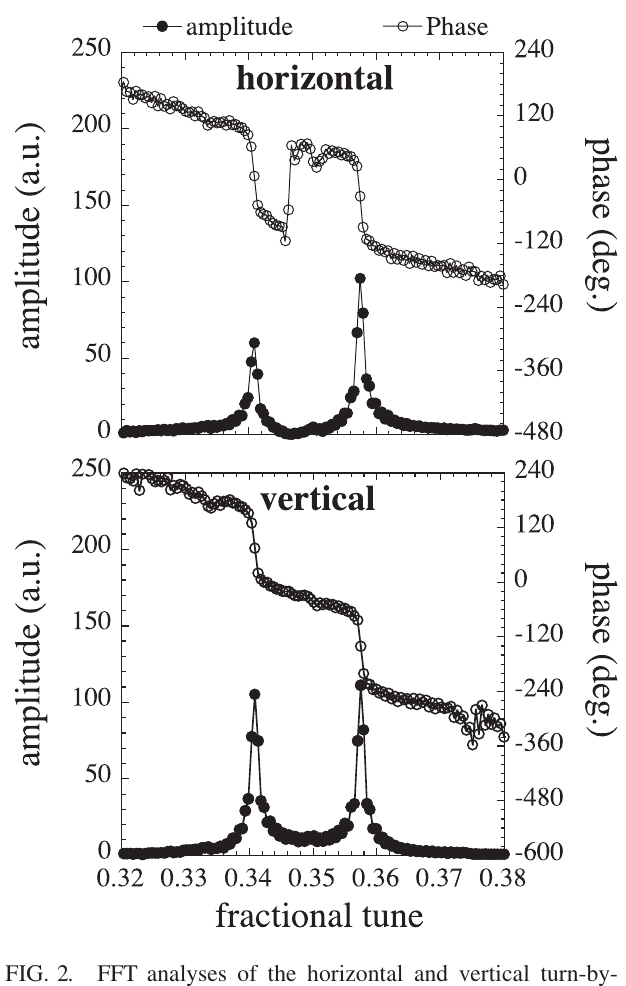
FIG. 2. FFT analyses of the horizontal and vertical turn-by- turn BPM data shown in Fig. 1. The turn-by-turn data are truncated at 1024 turns. Filled and open circles with solid lines show the amplitude and phase spectra, respectively. We see that the amplitude spectrum has the two peaks corresponding to the eigenmodes ð u; v Þ and the phase spectrum has the steeply inclined behaviors around the fractional tunes at the two peaks.